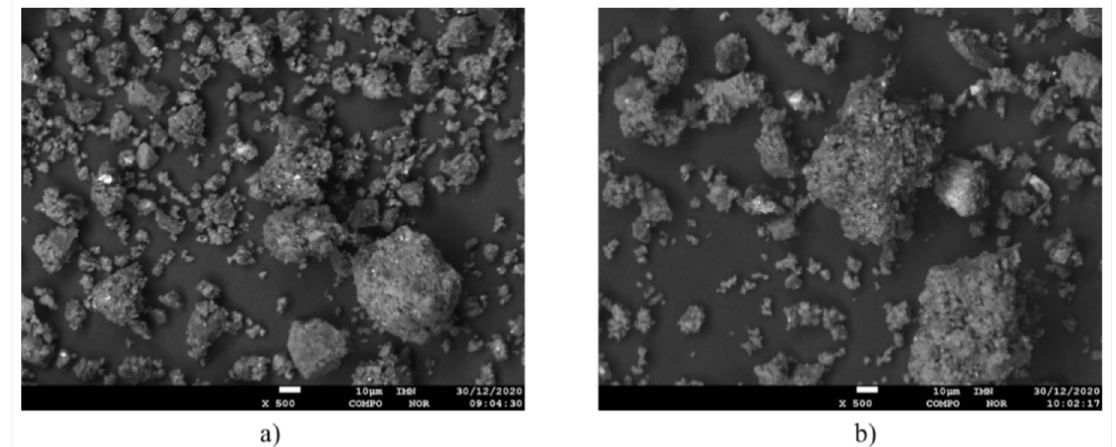
Figure 7. COMPO microscopic picture of the char obtained at the maximum temperature 400 ◦ C; zoom 500 × . ( a ) pre- consumer waste, ( b ) post-consumer